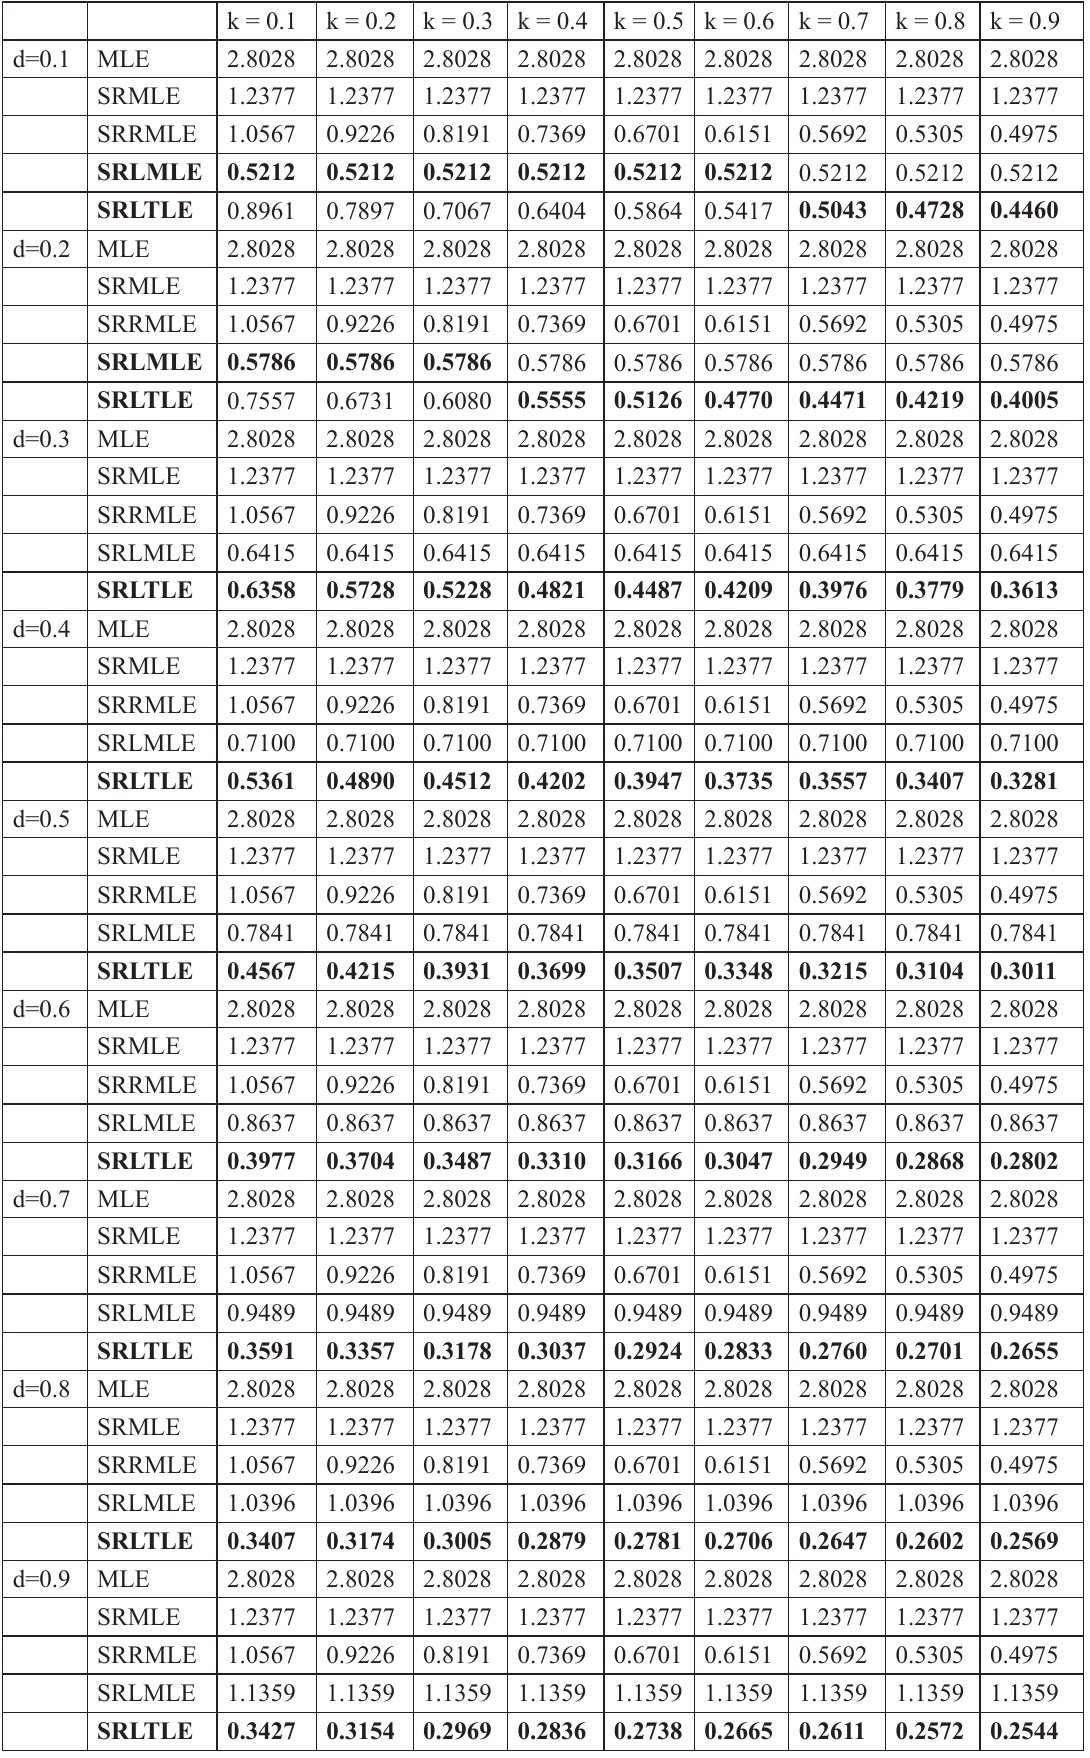
Table A4: The estimated MSE values for different k, d when n =15,